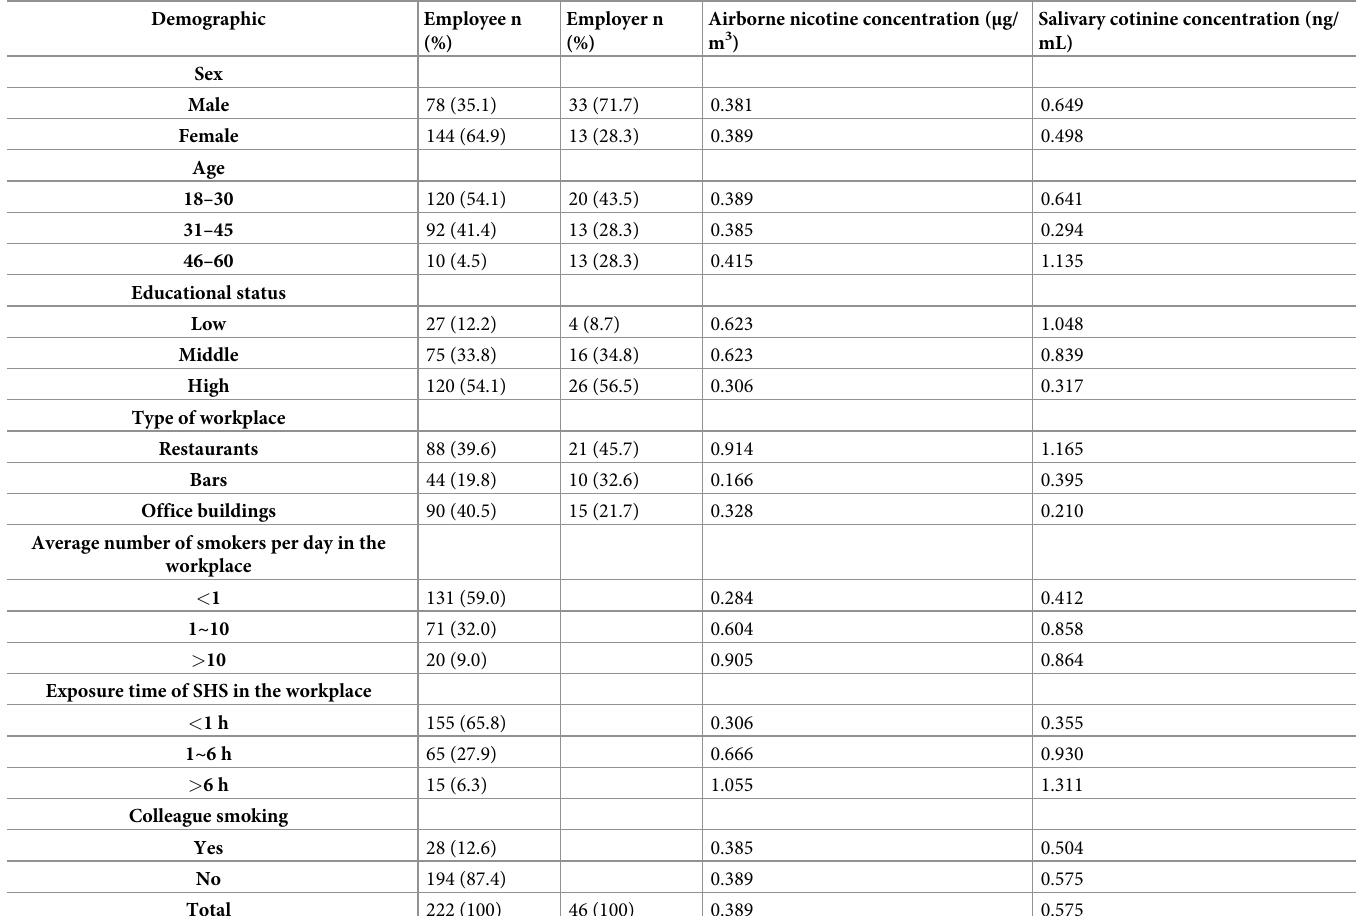
Table 1. Summary of the demographic